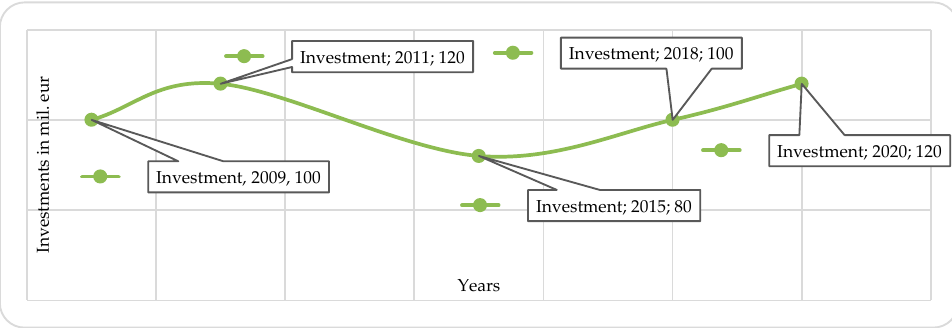
Figure 6. The most impactful investments of PSA Group SVK. Source: Authors’ compilation.